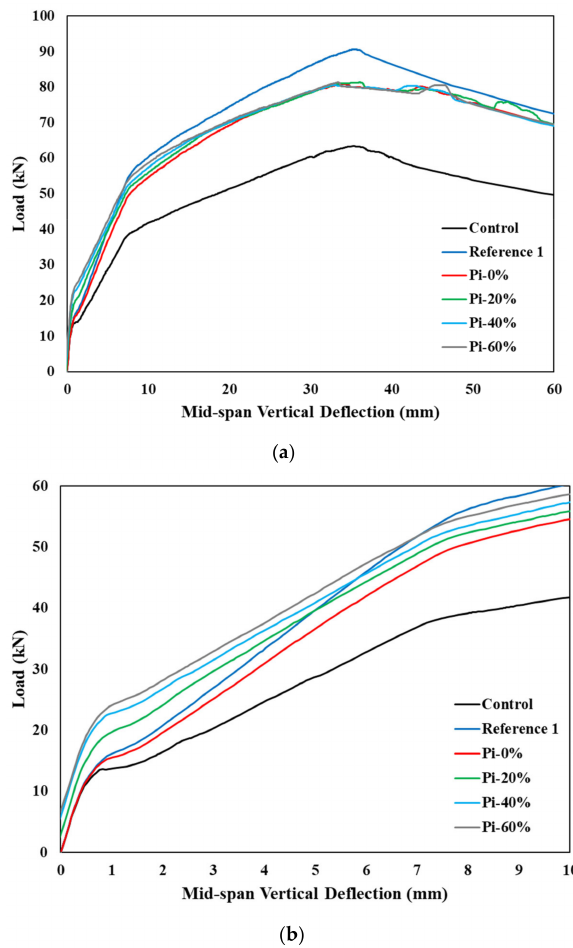
Figure 13. Load-deflection response for different pre-stressing levels: ( a ) full curve, ( b ) zoom of ( a